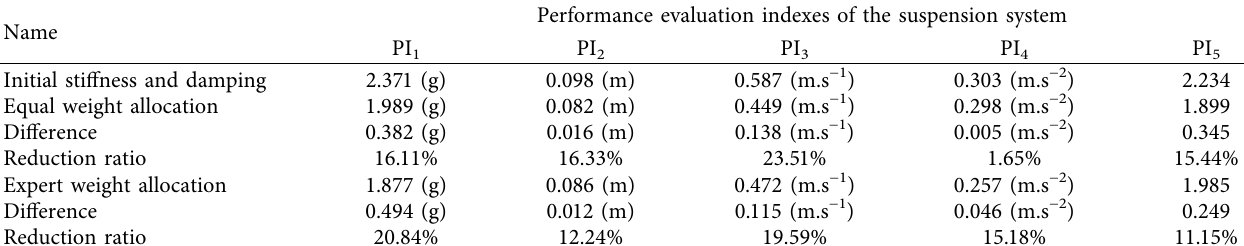
Table 3: Comparison of suspension system performance indexes.